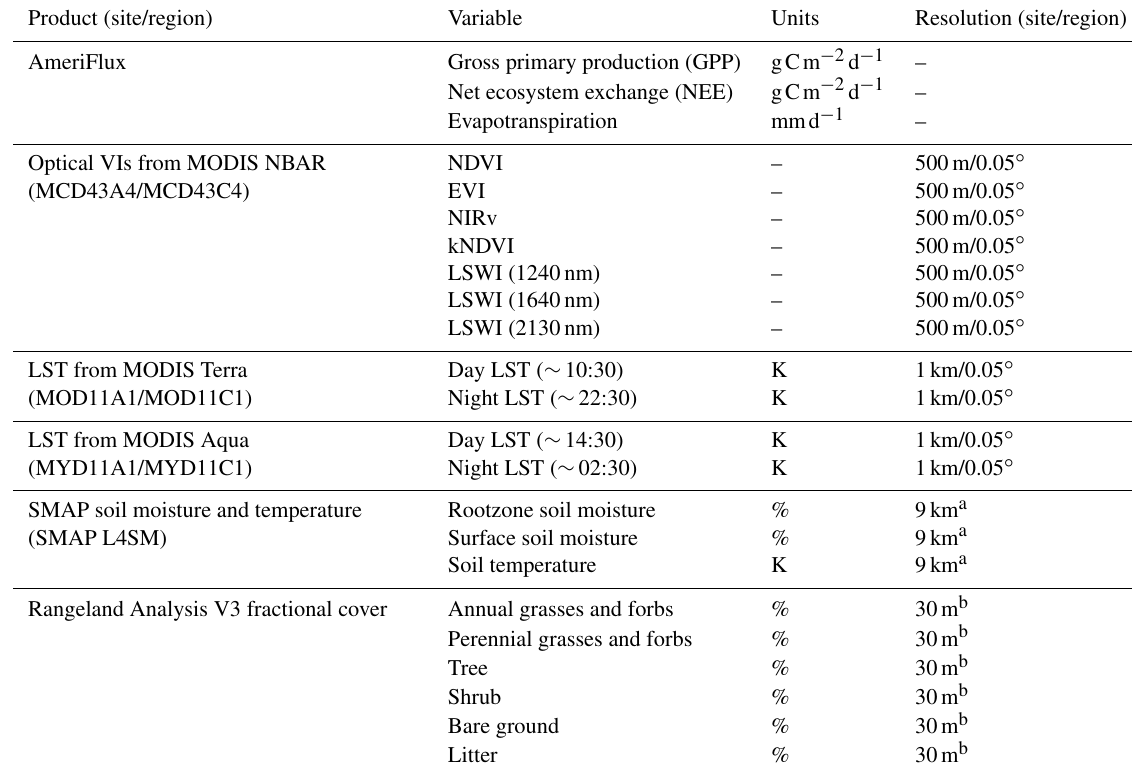
Table 1. AmeriFlux (response) and remote sensing (predictor) variables used in the DrylANNd carbon and water flux model. Product